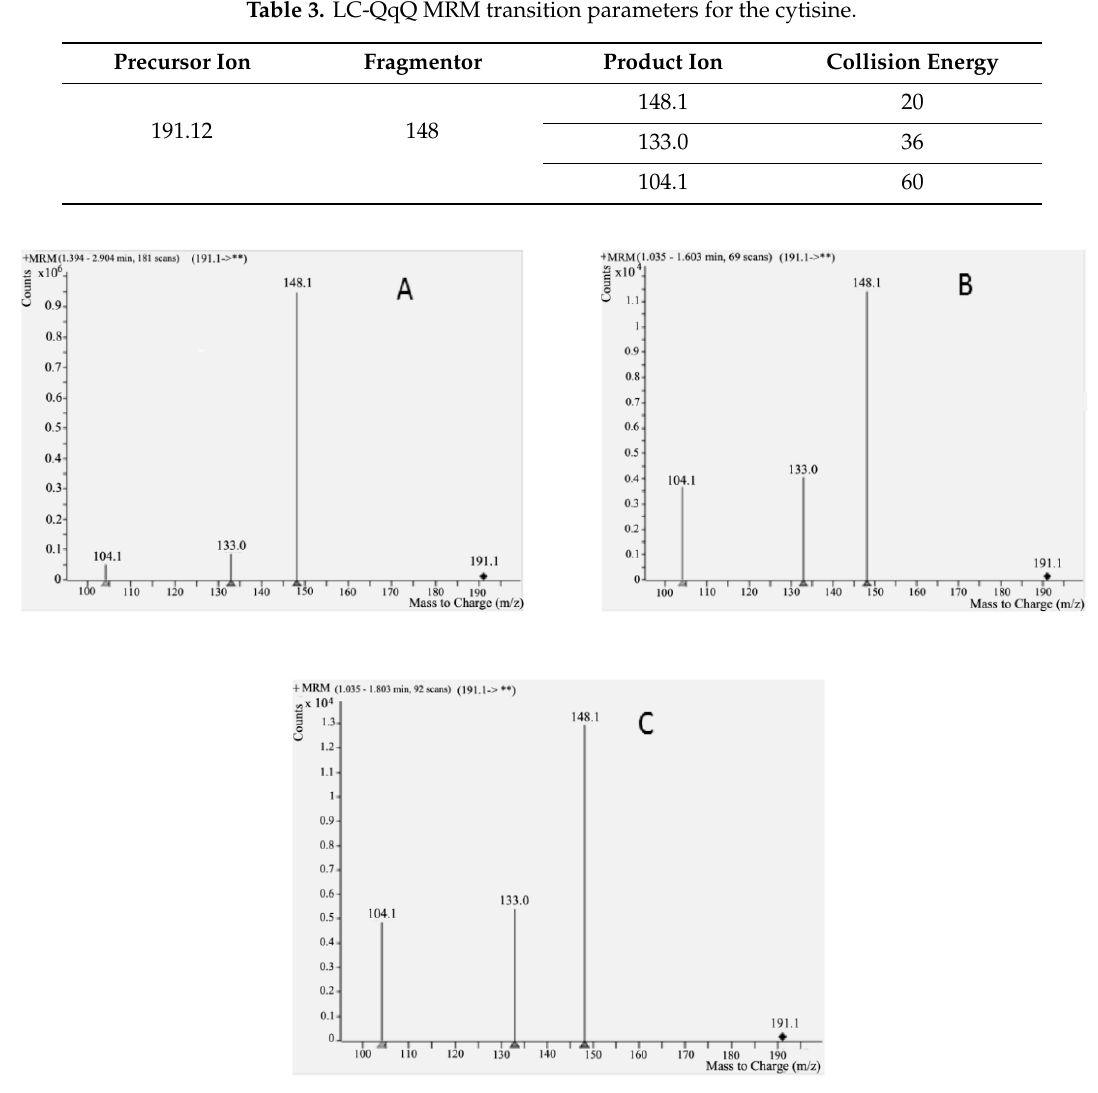
Figure 8. MS spectra obtained for: Cytisine standard ( A ), cytisine in saliva sample collected 1 h after single oral dose administration of 1.5 mg ( B ) and cytisine in saliva sample collected 24 h after single oral dose administration of 1.5 mg ( C ). Stationary phase: Synergi 2.5 µ L Polar-RP 100 Å; mobile phase – methanol: water + 0.1% HCOOH (82:18); flow: 0.3 mL/min; volume injected: 10 μ L.